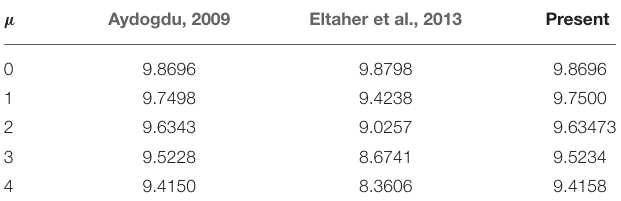
TABLE 2 | Comparisons of first fundamental frequency parameter ( λ ) for SS